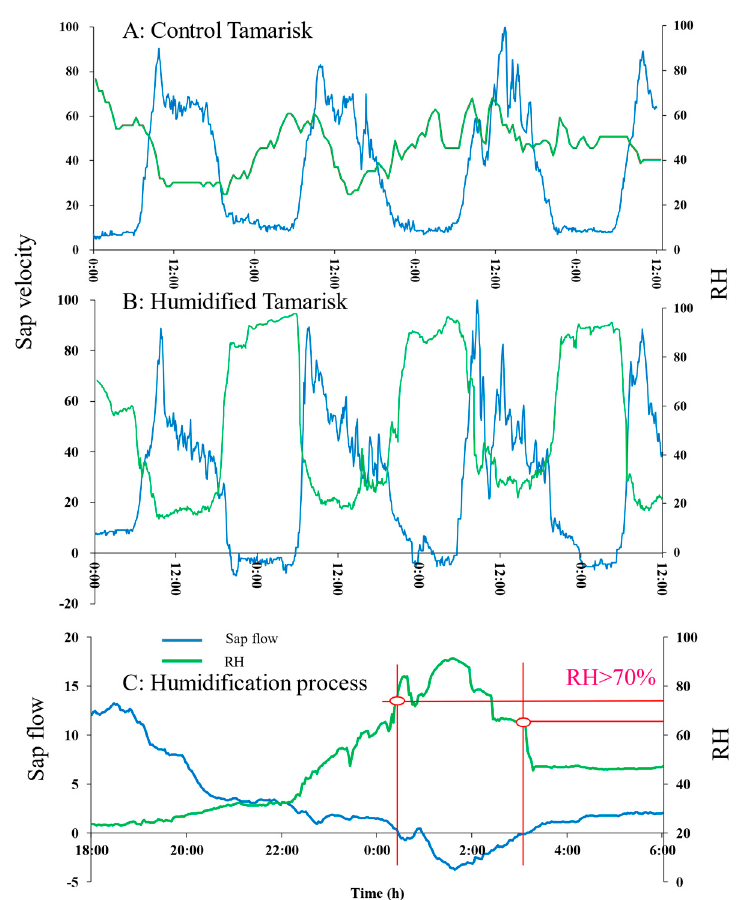
Figure 6. Time of occurrence of reverse sap flow. ( A ) The sap flow characteristics of Tamarisk in the in-situ state, ( B ) the sap flow characteristics of Tamarisk under humidified conditions. ( C ) The critical condition of reversed sap flow and corresponding RH, humidification process and dehumidification process.